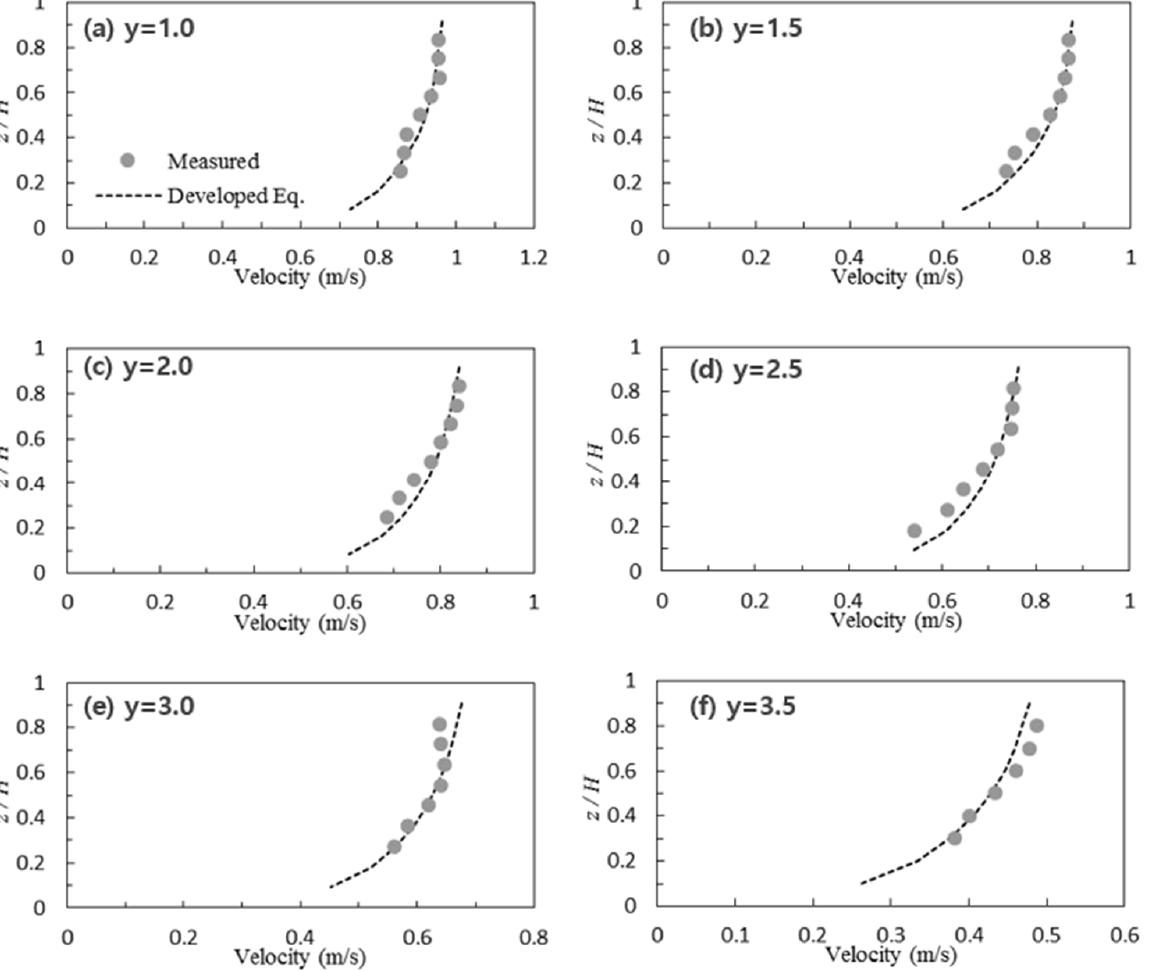
Figure 8. Comparison between measured velocity (dot) and that estimated by Equation (7) (line) at Section S5 of AMC 315 in nature-like channel.